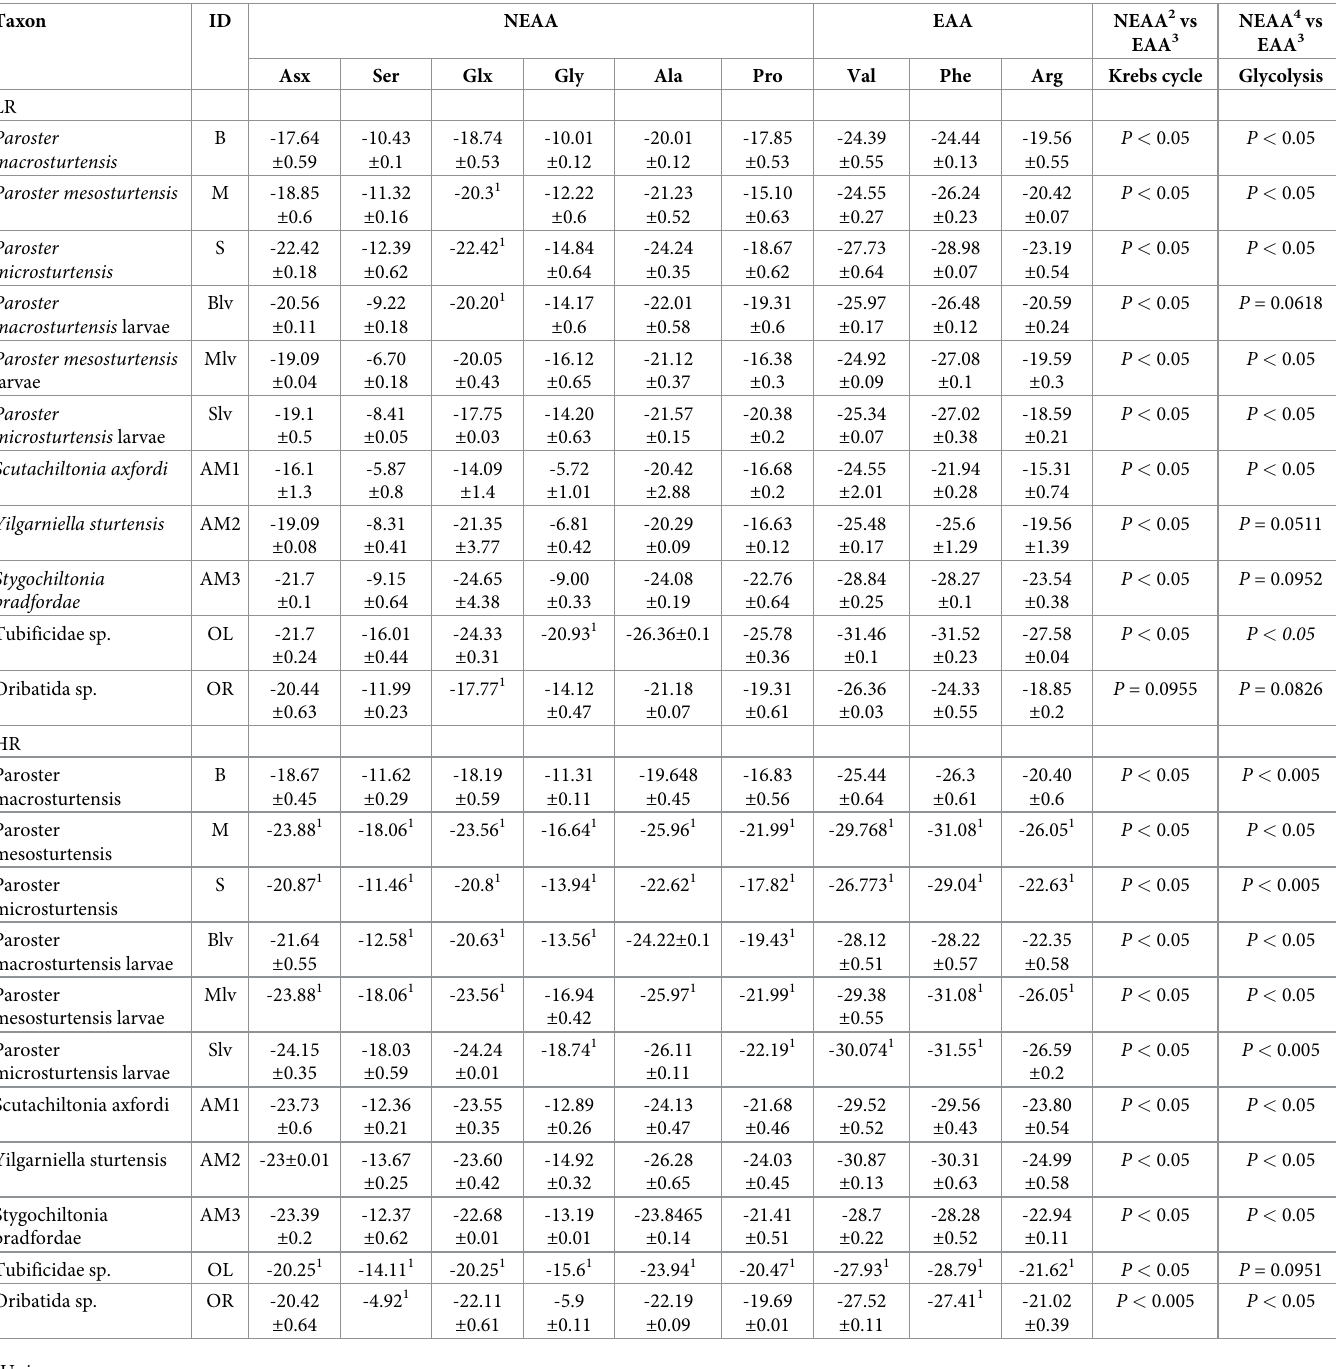
Table 1. Low (LR) and high rainfall (HR) carbon amino acids spectrum ( δ 13 C values) for stygofaunal specimens separated by non-essentials (NEAA: aspartic acid (Asx), serine (Ser), glutamic acid (Glx), glycine (Gly), alanine (ala), and proline (Pro)), and essentials (EAA: valine (Val), phenylalanine (Phe), and arginine (Arg)). Average values (and standard deviation) for the analytical replicates are shown. P values for ANOVA Tukey’s HSD pairwise comparisons between NEAA and EAA are also